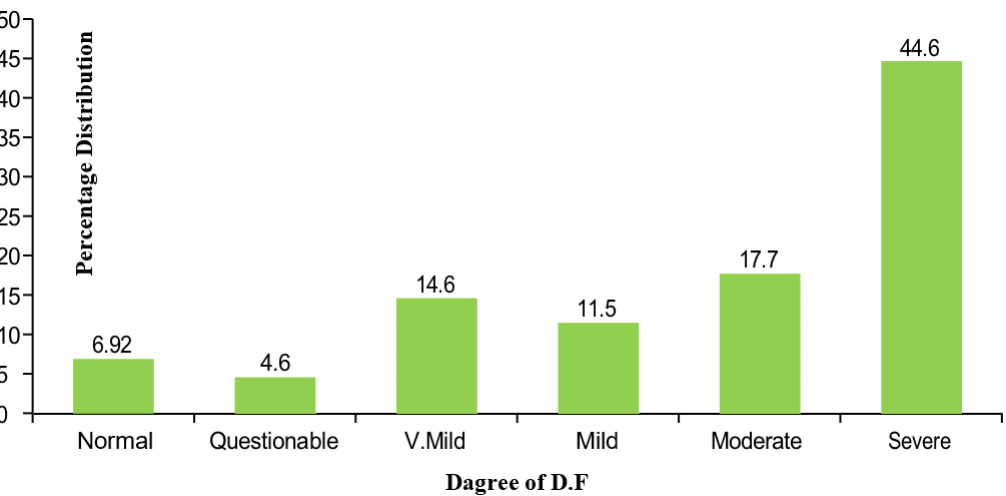
Figure 4: Percentage Distribution of Dental Fluorosis among Sample